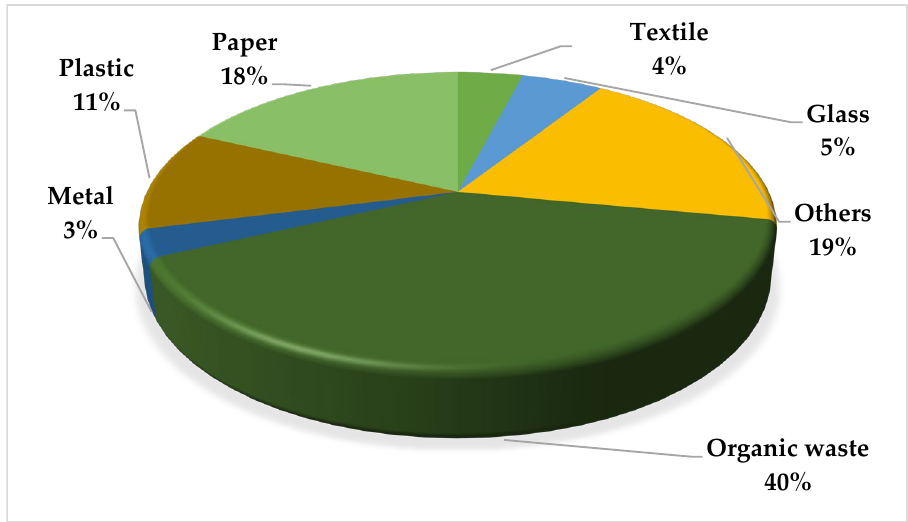
Figure 4. Percentage distribution of municipal solid waste in the European Union (year: 2021) (self-edited